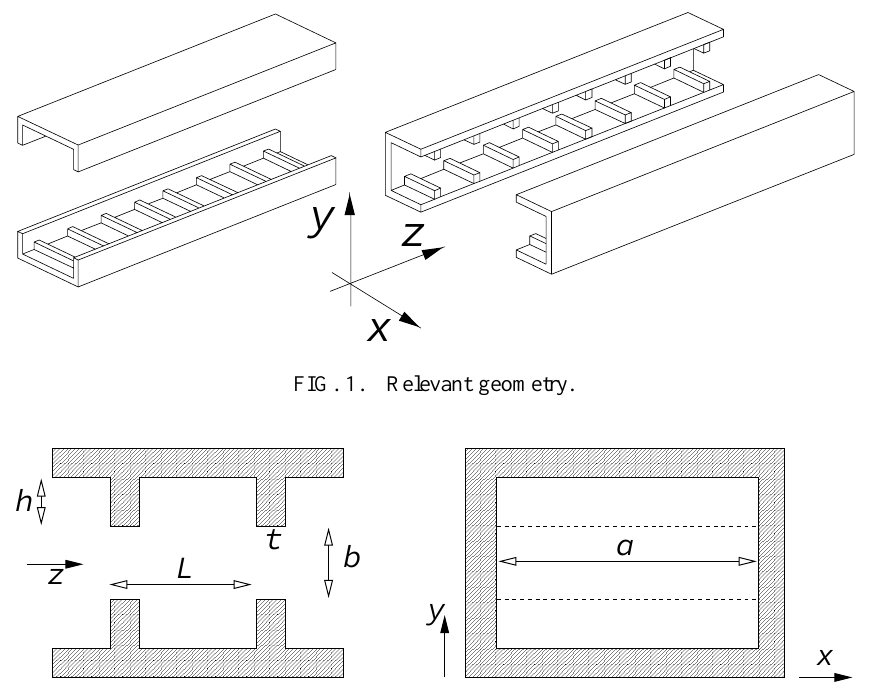
FIG. 2. Schematic view of the waveguide and notations